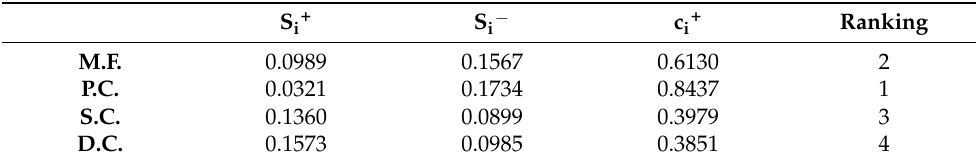
Table 14. S i+ , S i − and c i+ values and alternatives ranking based on the AHP-TOPSIS